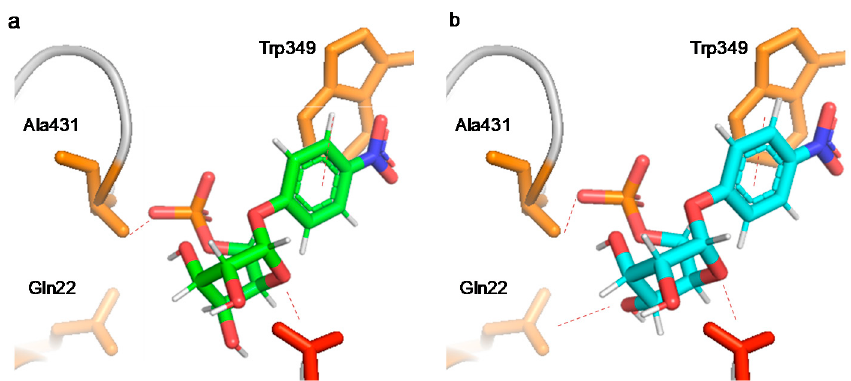
Figure 3. Lp_0440 in complex with ( a ) p NP-6P-Glu and ( b ) p NP-6P-Gal. Glu180 (active site) is marked in red, p NP-6P-Glu in green, and p NP-6P-Gal in blue. The protein structure was obtained from the Protein Data Bank (PDB code: 3qom) and the pictures were created using Pymol v. 0.99.